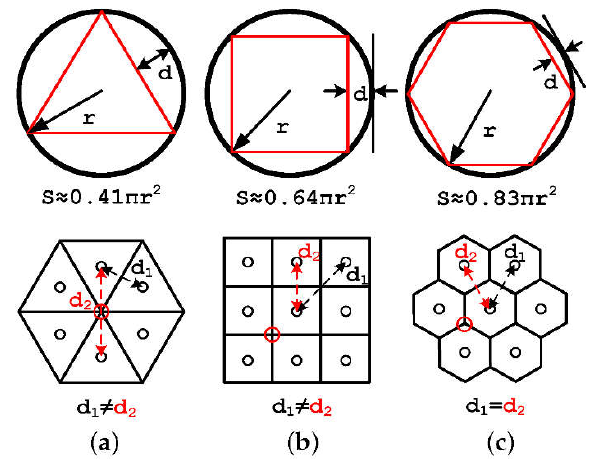
Figure 4 . A comparison of properties of regular grids: (a) Triangular, (b) orthogonal, (c) hexagonal (Uher et al., 2019).